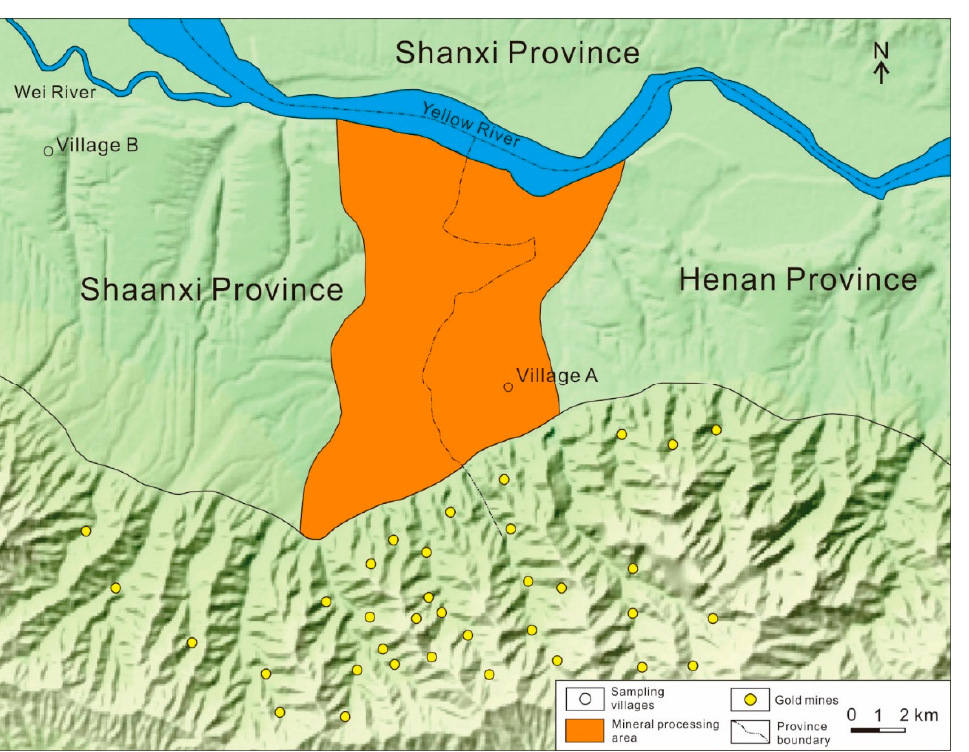
Figure 1. The map of the study area.